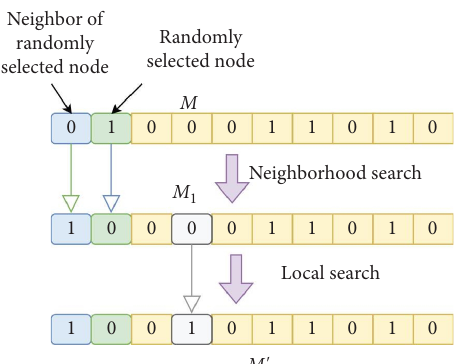
Figure 5: Illustration of on-wall inefective collision.